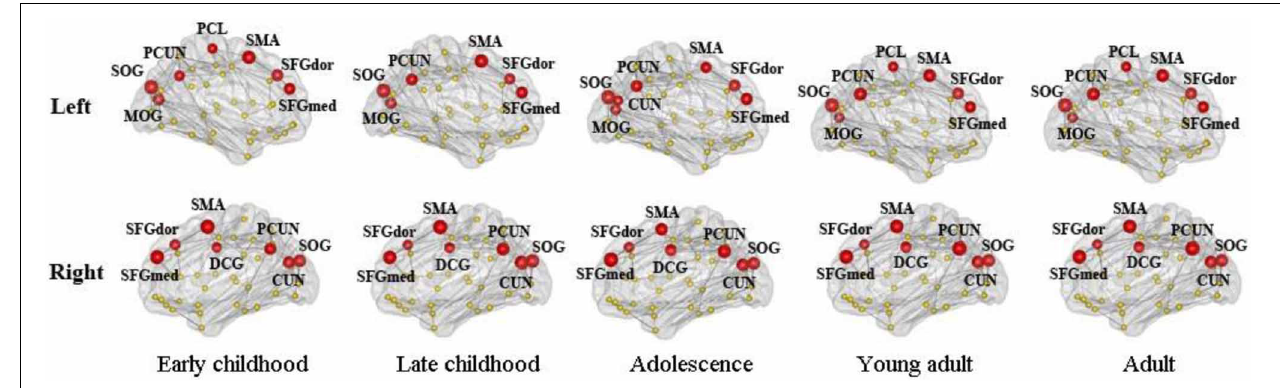
FIGURE 5 | Global hubs of the developing WM network defined by their nodal efficiency. Association hub regions such as bilateral PCUN, SFGdor, and SFGmed are consistent over all age groups. Note that all brain images are viewed from the medial side (also for Figures 6 , 7 ).